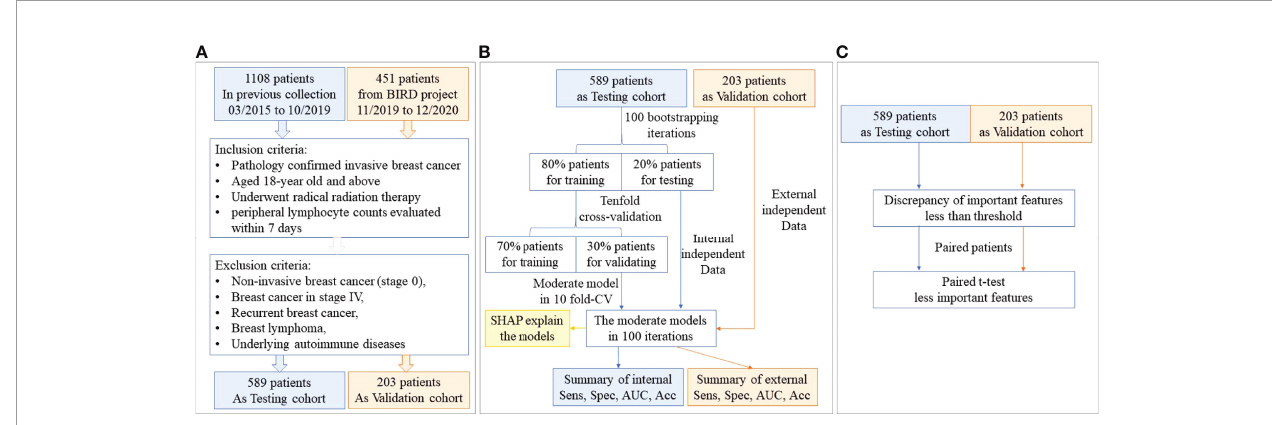
FIGURE 1 | The study fl owchart. (A) The patient fl owchart; (B) the machine learning fl owchart; (C) the statistical veri fi cation fl